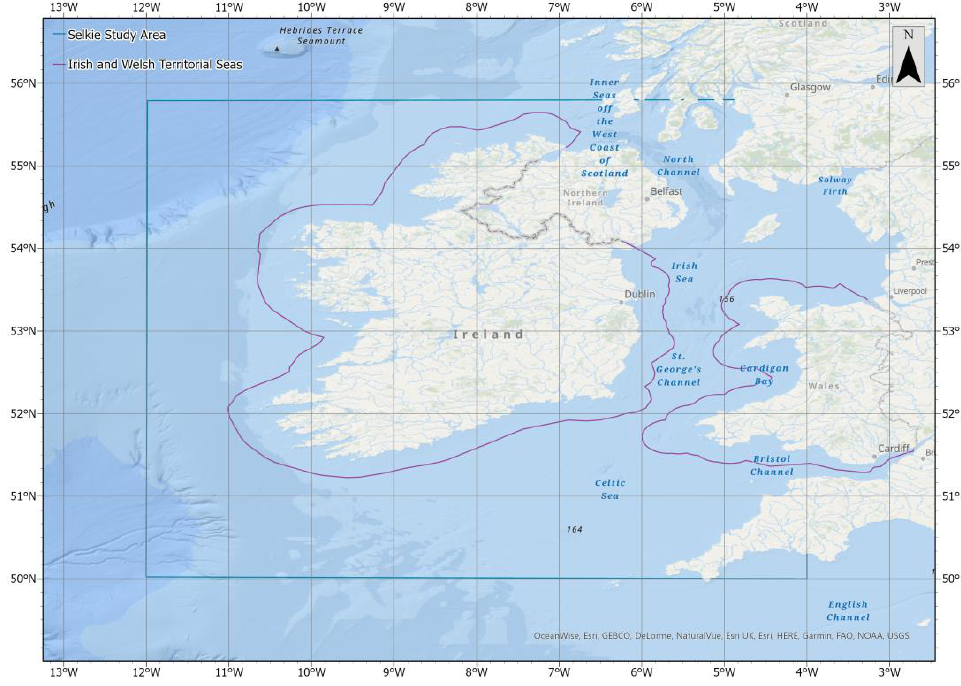
Figure 2. The Selkie Study Area extending beyond the Irish and Welsh Territorial Seas. Table 1. Details of wave data